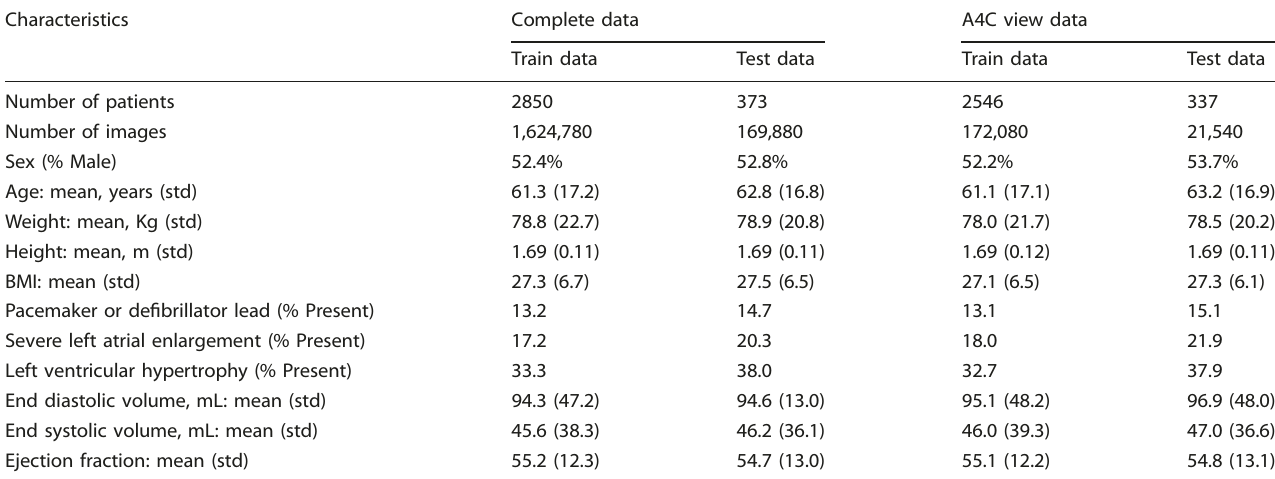
Table 1. Baseline characteristics of patients in the training and test